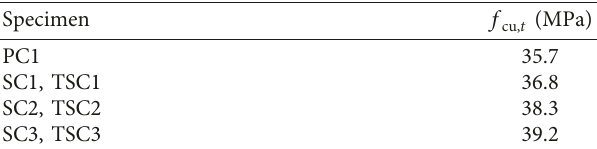
Table 3: Concrete strength for the aeolian concrete specimens.